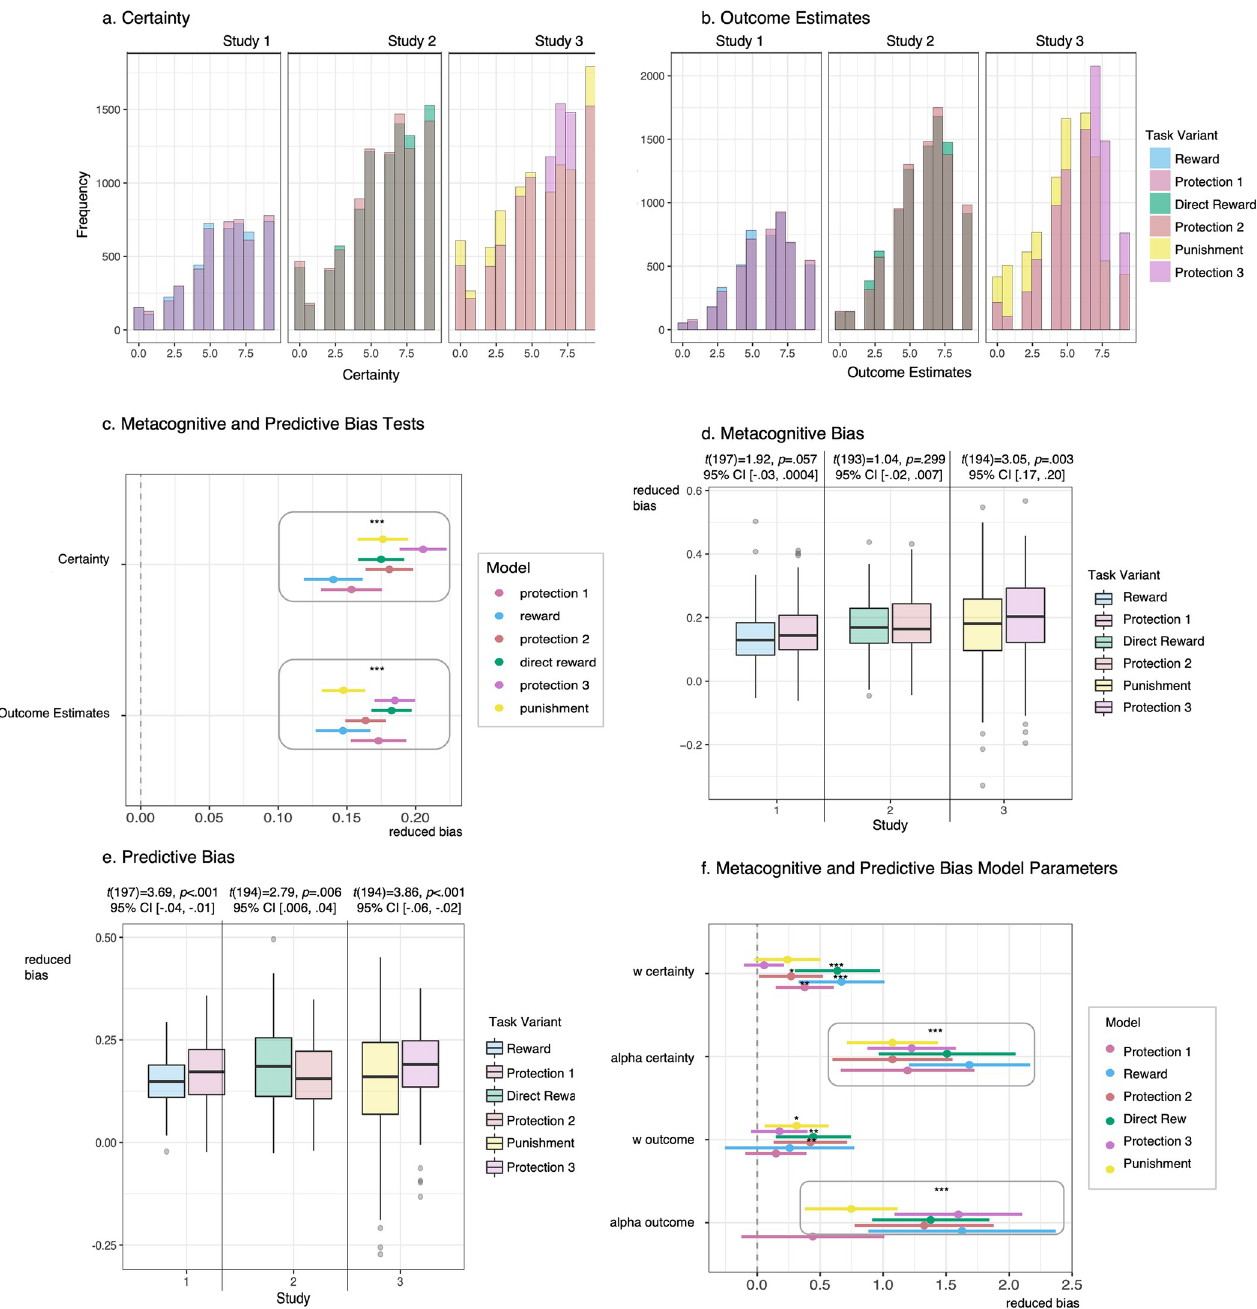
Fig 3. Metacognitive and predictive bias results. a. Histograms depicting Certainty ratings by study and task variant. Certainty was rated with respect to how sure subjects felt they were that they selected the first-stage state that would lead to the most optimal outcomes. Certainty ratings were made on a scale of 0–9 from not at all certain to very certain. b. Histograms depicting Outcome Estimates by study and task variant. Outcome Estimates were provided with respect to how many outcome units subjects thought they would receive at the second-stage. Outcome Estimates were made on a scale of 0–9 outcome units (i.e., subjects who rated a 2 thought they would receive 2 shields/sacks/coins/flames, respectively). c. Mixed-effects model parameters testing metacognitive and predictive bias by modeling actual outcome received as a function of Certainty and Outcome Estimates, respectively. d. Metacognitive bias boxplots by study and task variant. Metacognitive bias was calculated by extracting random slope coefficients from the model of outcome predicting Certainty. Significant differences were only identified in Study 3 with reduced bias for the protection acquisition variant compared to the punishment avoidance variant. e. Predictive bias boxplots by study and task variant. Predictive bias was calculated by extracting random slope coefficients from the model of outcome predicting Outcome Estimates. Significantly reduced bias was revealed for the protection acquisition variants compared to the reward acquisition and punishment avoidance variants, but not compared to the direct reward variant. f. Model parameters for metacognitive and predictive bias coefficients regressed against model-based control weighting